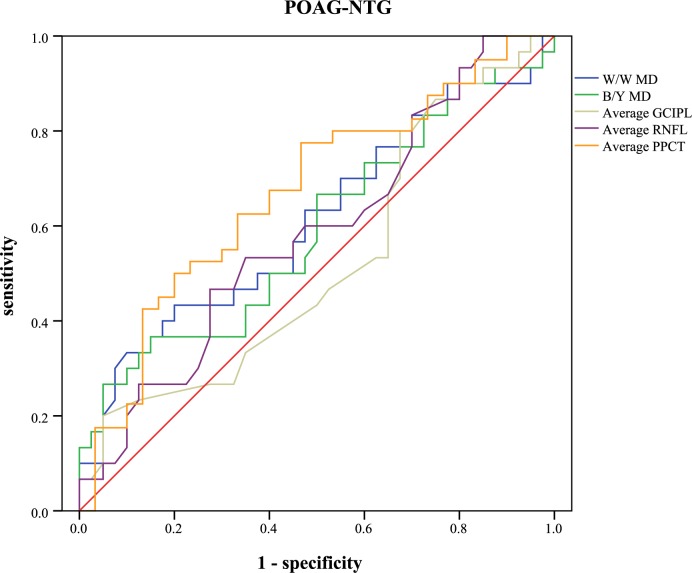
ROC curves for visual field indices and OCT parameters to discriminate POAG from NTG eyes.